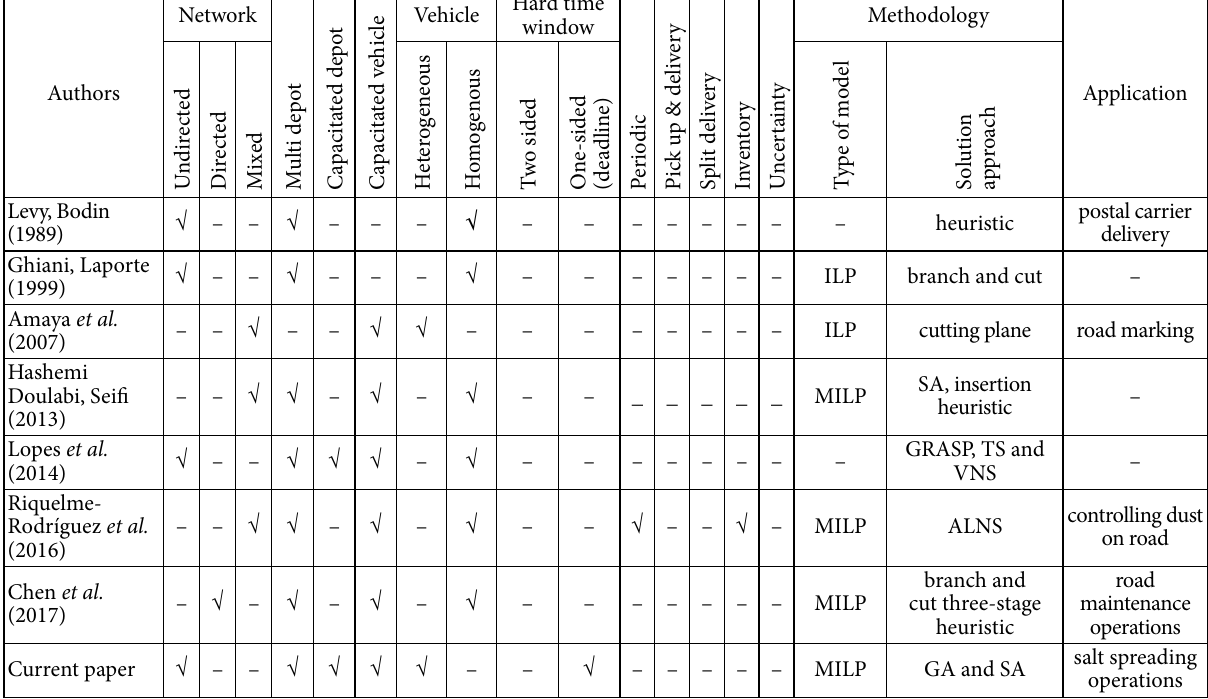
Table 2. Different aspects of developed LARP models in previous